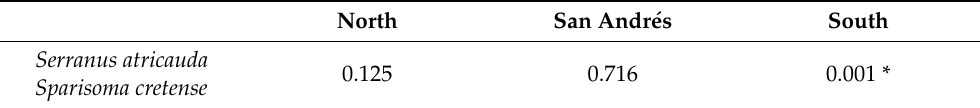
Table 8. Results of the two-way PERMANOVA analyzing the variation in the content of heavy metals and trace elements in liver tissue in species according to study zone, considering the level of the factor “Zones”.